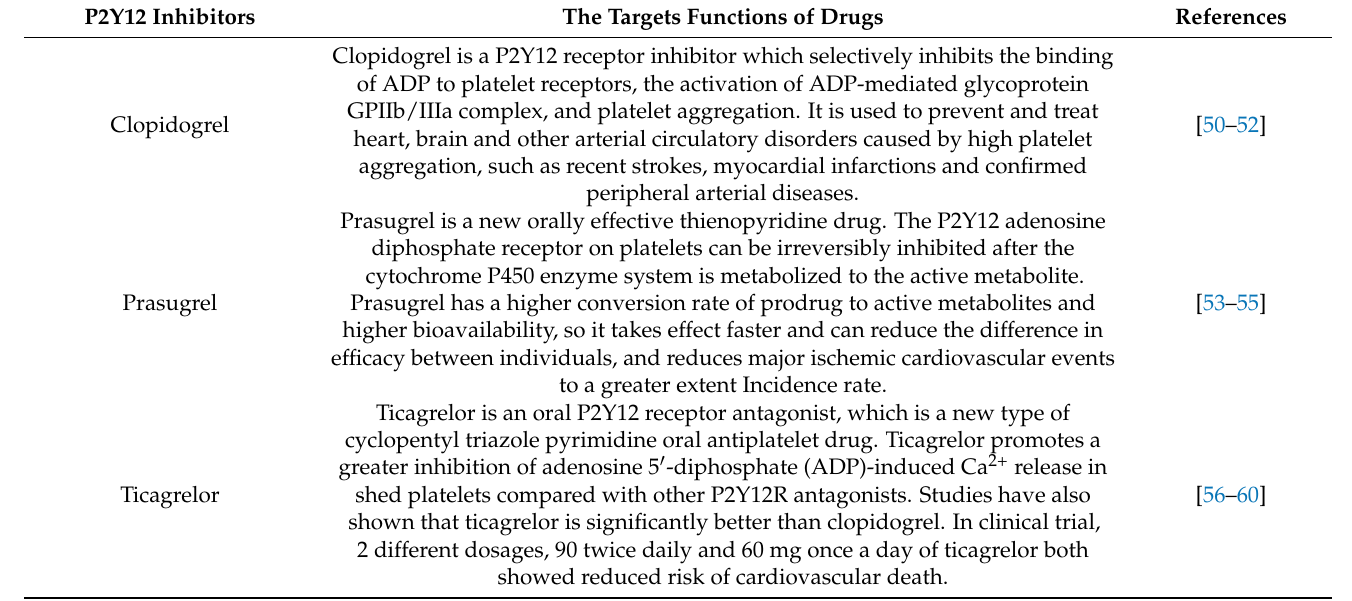
Figure 1. The activation of P2Y12 receptor in platelet activation and other biological process. Table 1. The treatment drugs of diseases based on P2Y12